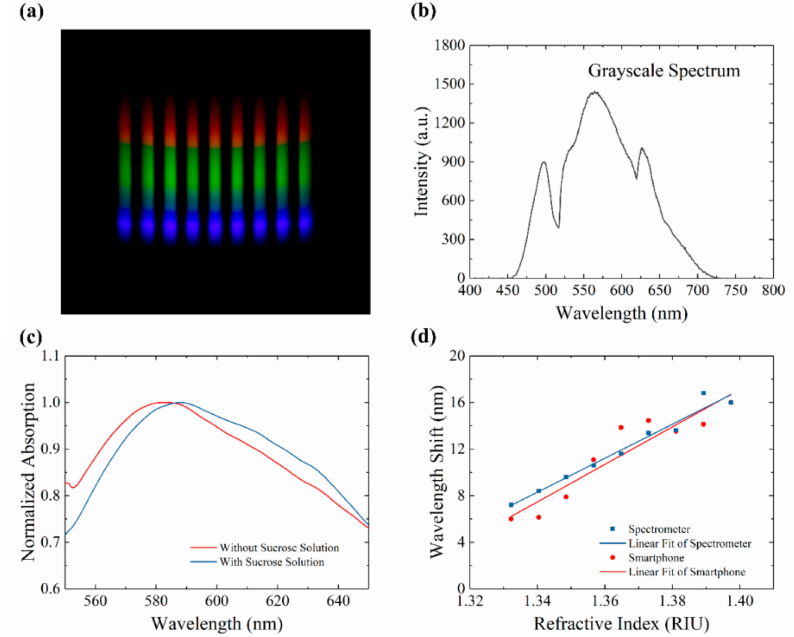
Figure 4. Results of refractive index measurement. ( a ) Picture taken by the smartphone on the SBSM. ( b ); The grayscale spectrum of the rainbow picture; ( c ) Normalized absorption spectrum with and without sucrose solutions; ( d ) Relationship between wavelength shift and refractive index measured by the smartphone and the